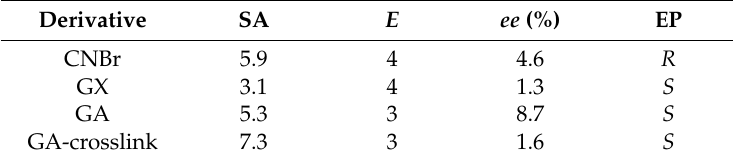
Table 7. Activity and enantioselectivity of lipase derivatives in the hydrolysis of racemic -1- phenylethanol